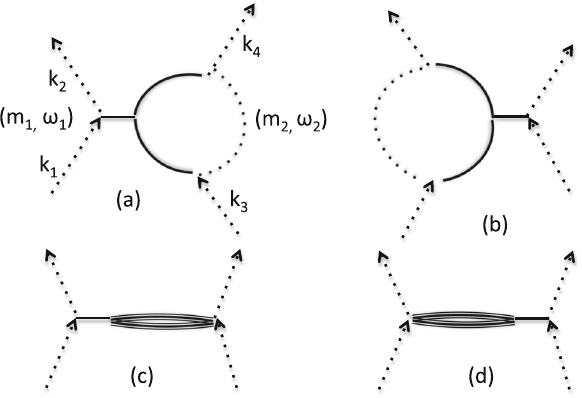
Fig. 5 Two classes of the set of one particle reducible diagrams yield non-analytic corrections to the potential. The solid lines denote the